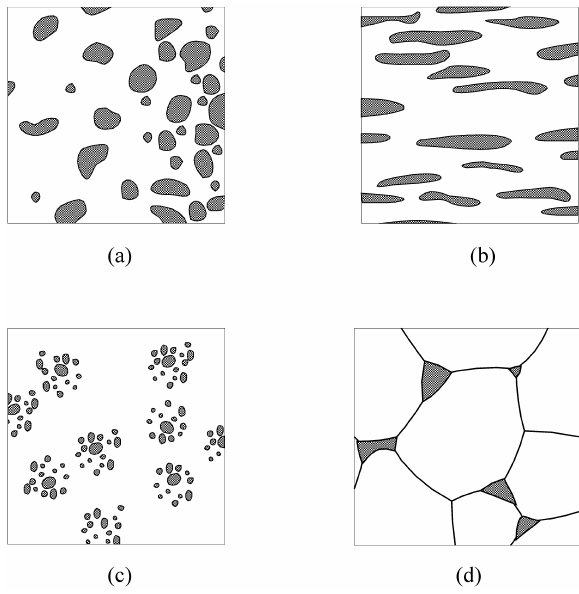
Figure 5. Microstructures illustrating the concepts of (a) gradients, (b) anisotropies, and (c) associations.